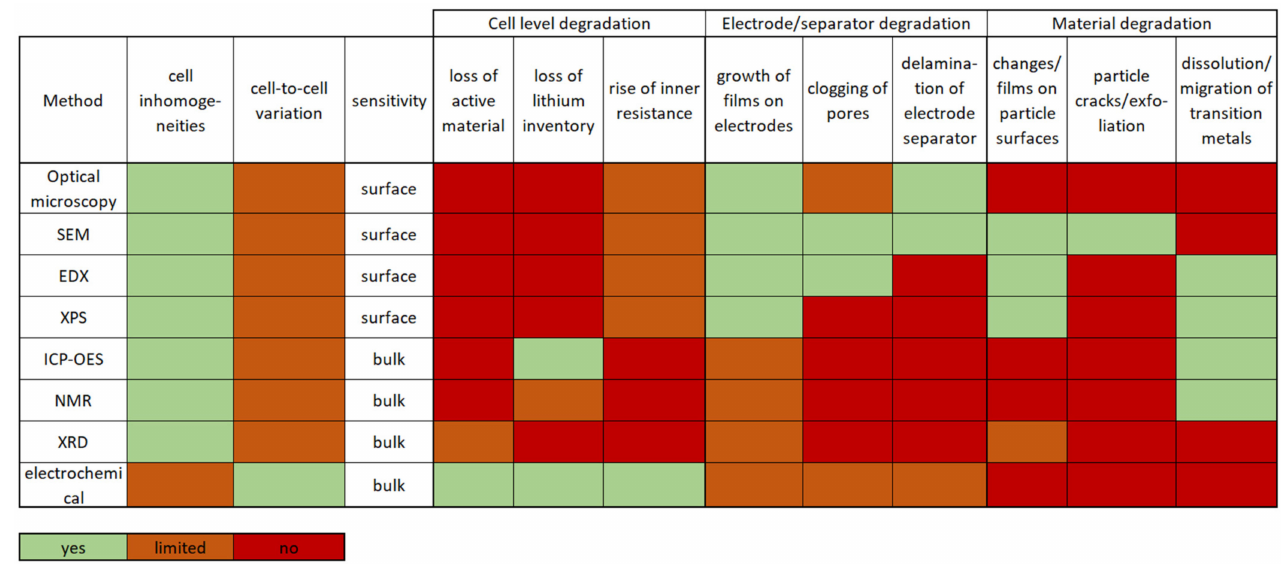
Figure 11. Post-mortem analysis methods (modified from Waldmann et al., 2016 CC BY 4.0